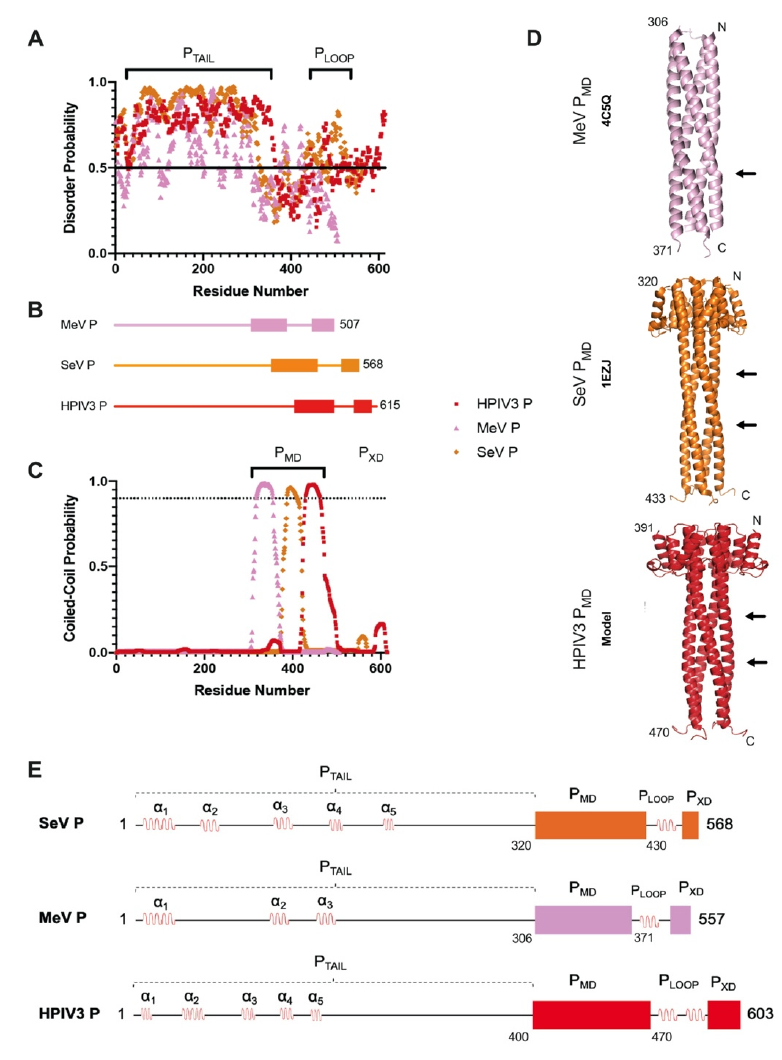
Figure 1. Construct design and homology P MD structures based on measles and Sendai virus structural information. ( A ) Individual residue disorder probability from IUPred; IUPred scores were plotted for each residue in the query sequences. ( B ) Overall domain architecture of the different phosphoprotein. ( C ) Coiled-coil probability scores (P-score) were plotted against the residue number of the different phosphoproteins using the WaggaWagga server, showing a coiled-coil P MD close to the C-terminus. ( D ) PDB structures of MeV P MD (4C5Q) and SeV P MD (1EZJ), HPIV3 P MD was modeled using SeV P MD as a template based on sequence identity. Arrows indicate coiled-coil kinks. ( E ) Detailed sequence analysis for all three viruses. Black lines, disordered regions; red loops, short alpha-helical regions; rectangles, phosphoprotein multimerization domain; squares, C-terminal domain (XD). Orange, pink, and red colors represent SeV P, MeV P, and HPIV3 P, respectively.